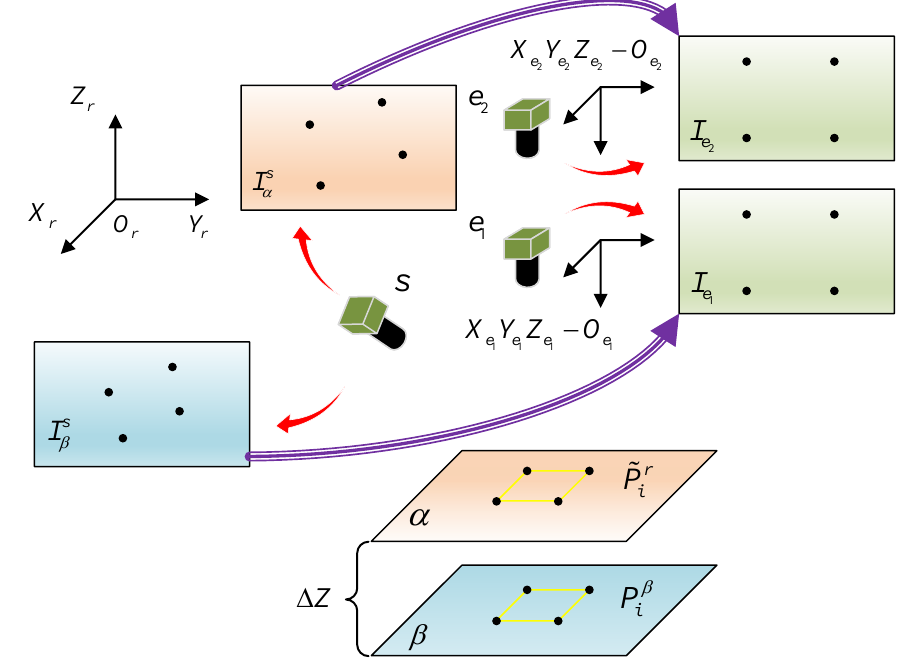
Figure 3. The relationship between camera pose and viewing